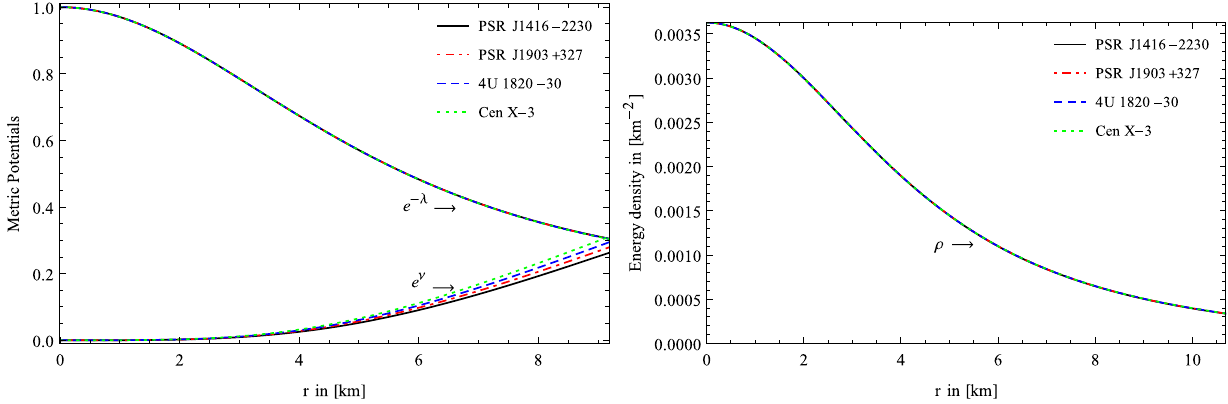
Fig. 1 The variation of metric potentials (left panel) and energy den- sity (right panel) with the radial coordinate r for experimental statis- tics of four different compact stars. For plotting these graphs, the